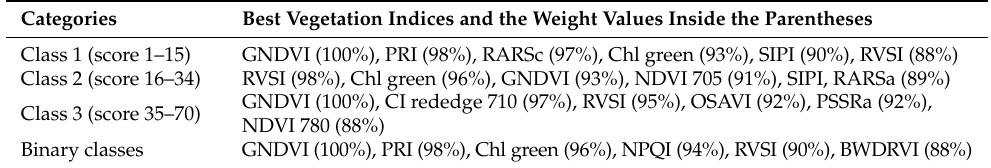
Figure 6. The overall classification accuracy of vegetation indices by applying different classification methods: SVM, DTC, QDA, and RFC. Table 3. The result of VIs selection in random forest classifier for multi-classes and binary classifi- cation. Categories